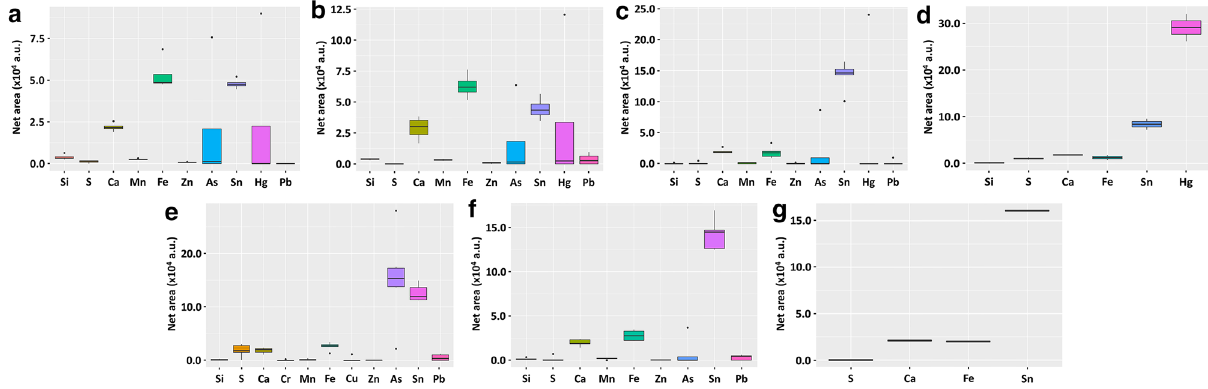
Figure 6. Elemental composition and distribution of Kinkarakawa-gami wallpapers obtained through XRF spectroscopy. XRF results are depicted by comparing artefacts’ sampling points collected for ( a ) verso (INV_11_2, INV_13_2, INV_15_2, INV_20_2), ( b ) written portions of verso (INV_11_1, INV_13_1, INV_15_1, INV_20_1) and ( c ) recto’s background (INV_11_5, INV_11_7, INV_13_3, INV_15_3, INV_20_5), as well as ( d ) red (INV_11_6, INV_15_4), ( e ) green (INV_11_3, INV_11_8, INV_11_9, INV_13_4, INV_13_8, INV_20_3), ( f ) brown (INV_11_4, INV_11_5, INV_13_6, INV_13_7, INV_13_9), and ( g ) black (INV_11_10)